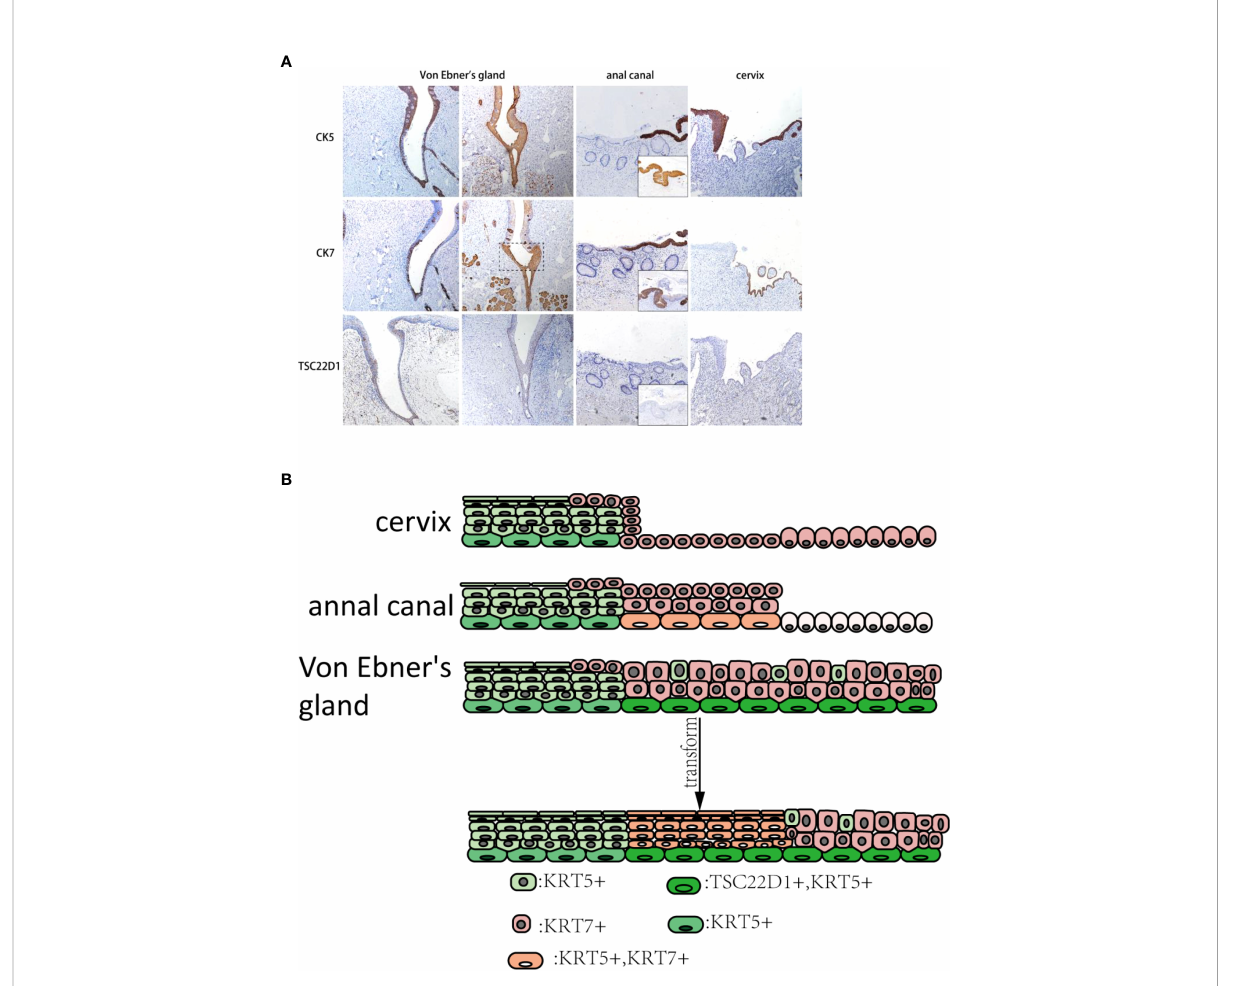
FIGURE 4 (A) CK5, CK7, and TSC22D1 IHC staining in the human cervix, anus, and Von Ebner ’ s gland. The dashed line is shown in the CK7-positive squamous metaplasia of human Von Ebner ’ s gland, where CK5 is also expressed. In contrast, normal Von Ebner ’ s gland has no CK5+/CK7+ multilayered epithelium. TSC22D1 was only expressed in the squamous metaplasia zone and columnar epithelial areas of Von Ebner ’ s gland. CK5+/CK7+ multilayered epithelium can be seen in the anal SCJ. CK5+/CK7+ squamous metaplastic island can be seen in the cervix (×10). (The lower right of the anal canal diagram shows the junction of the transitional zone with the squamous epithelium.) (B) Pattern diagram of the transformation zone in the cervix, anus, and Von Ebner ’ s